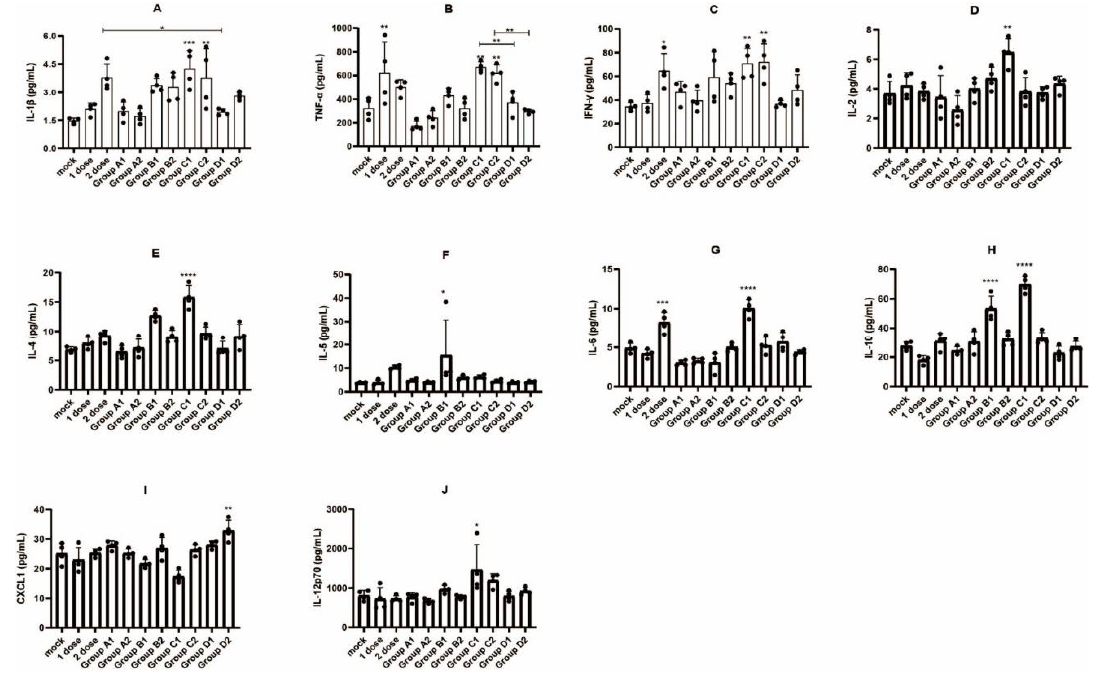
Figure 6. Proinflammatory cytokine analysis of serum samples collected from mice at the time of sacrificing after completion of the immunization procedure. ( A ) IL-1β, ( B ) TNF-α, ( C ) IFN-γ, ( D ) IL-2, ( E ) IL-4, ( F ) IL-5, ( G ) IL-6, ( H ) IL-10, ( I ) CXCL1, and ( J ) IL-12p70. 1 dose: 1 dose inactivated vaccine control group; 2 dose: 2 doses inactivated vaccine control group; one-way ANOVA (and nonparametric or mixed) was conducted; * p < 0.05; ** p < 0.01; *** p < 0.001; **** p < 0.0001 versus the control group.